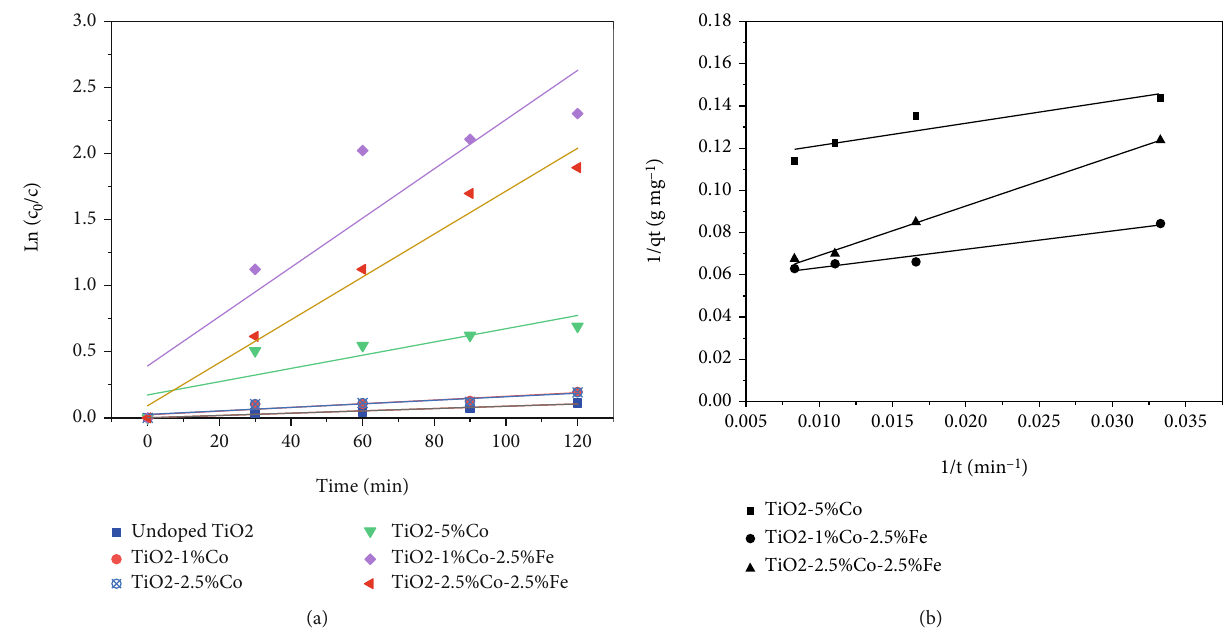
Figure 8: Plots of (a) fi rst- and (b) second-order reaction rates for the degradation of MB over as-prepared TiO